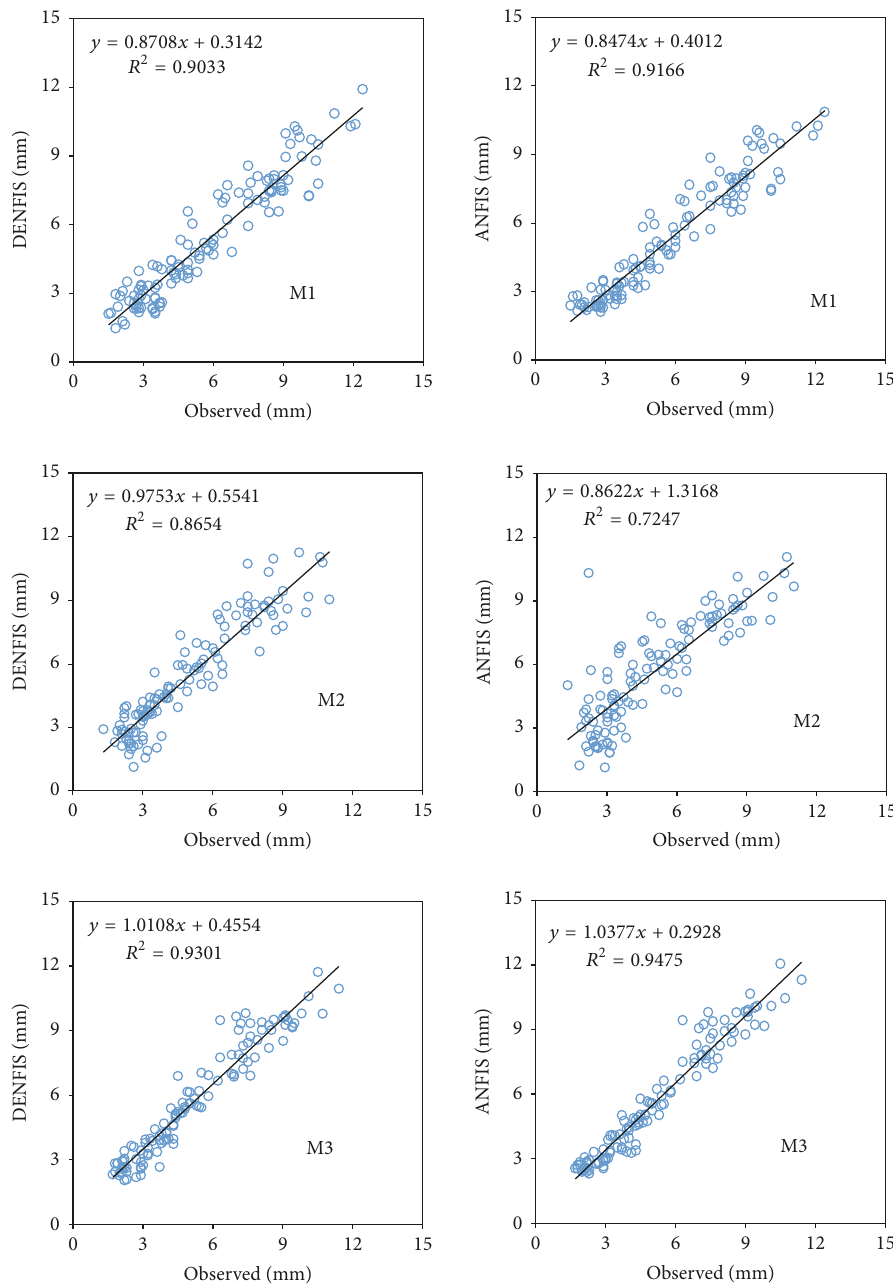
Figure 2: The observed and estimated pan evaporation using DENFIS and ANFIS methods for the M1, M2, and M3 data sets—Antalya.